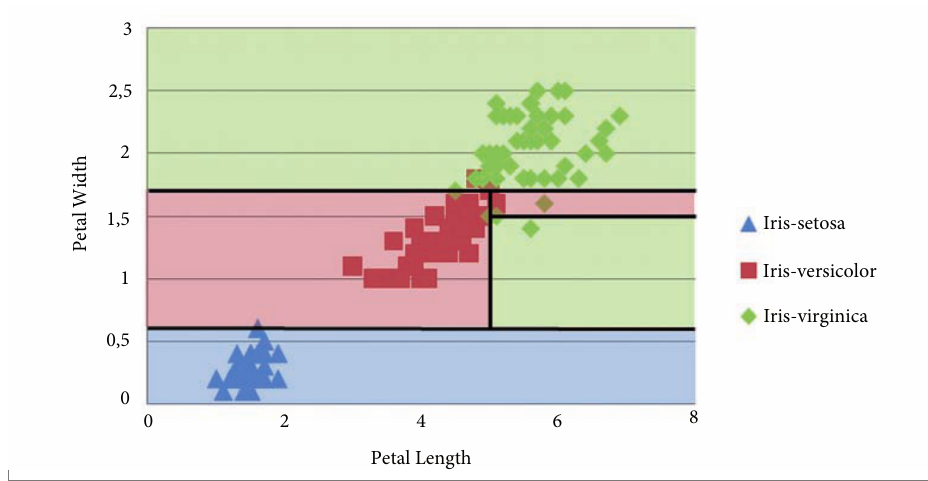
Fig. 3. Three classes of Iris data set classified using C4.5 – Iris-Setosa fully separated at the lower part and other two classes overlap a little causing